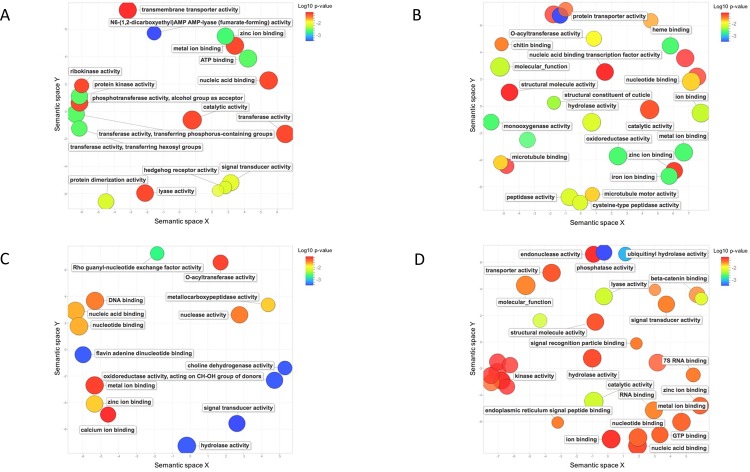
Molecular functions of significantly expressed D. noxia biotype 2 transcript clusters.(A) Clusters uniquely up- regulated in response to susceptible plants containing Dn4; (B) clusters up—regulated in response to Dn4 plants but down-regulated in response to resistant plants containing Dn7; (C); clusters uniquely up- regulated in response to Dn7 plants; (D) clusters up—regulated in response to Dn7 plants but down-regulated in response to Dn4 plants. Bubble color indicates p-value (legend in upper right-hand corner), bubble size indicates GO term frequency. See Methods Section for explanation of plot derivation.